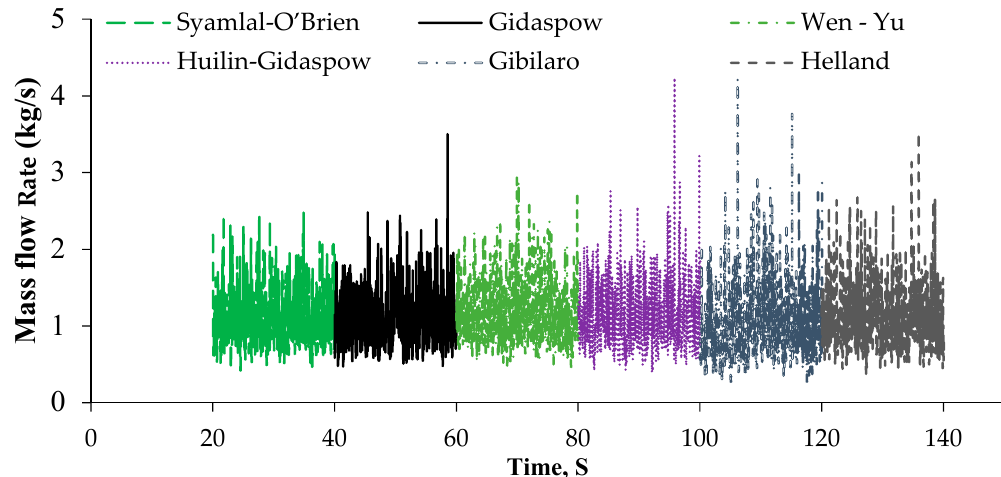
Figure 3. Influence of drag models on the outlet mass flow rate.